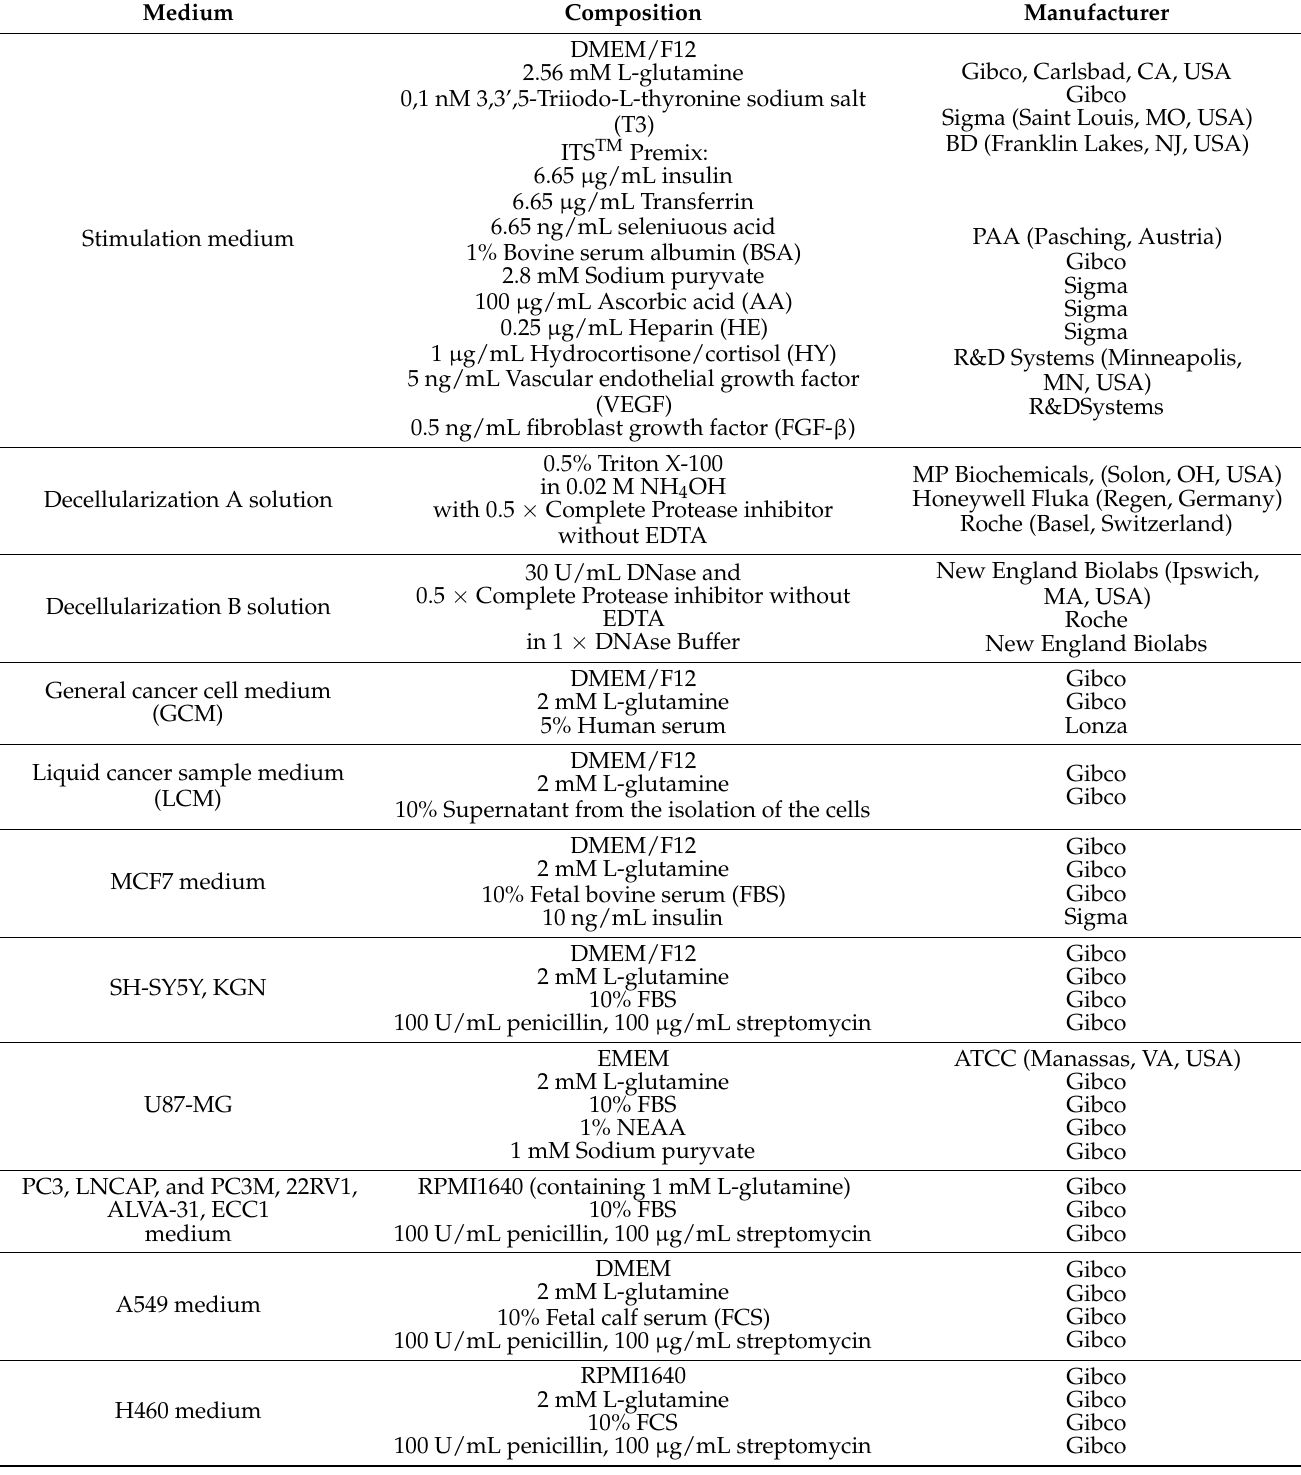
Table 1. Composition of media and solutions used in the study and their